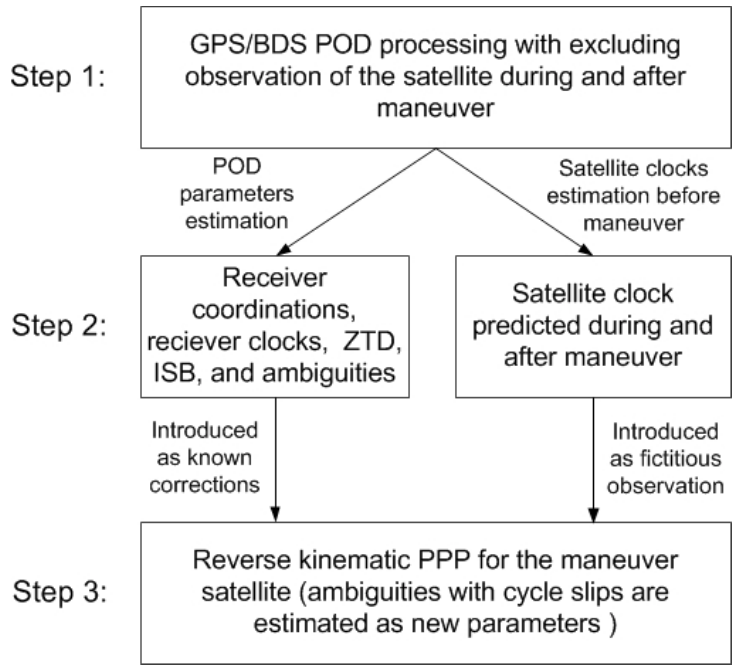
Figure 2. Processing scheme of the clock-constrained reverse precise point positioning (RPPP) precise orbit determination (POD) strategy for maneuvering satellites. GPS—global positioning system; BDS—Beidou navigation satellite system; ZTD—zenith tropospheric delays; ISB—inter-system bias.